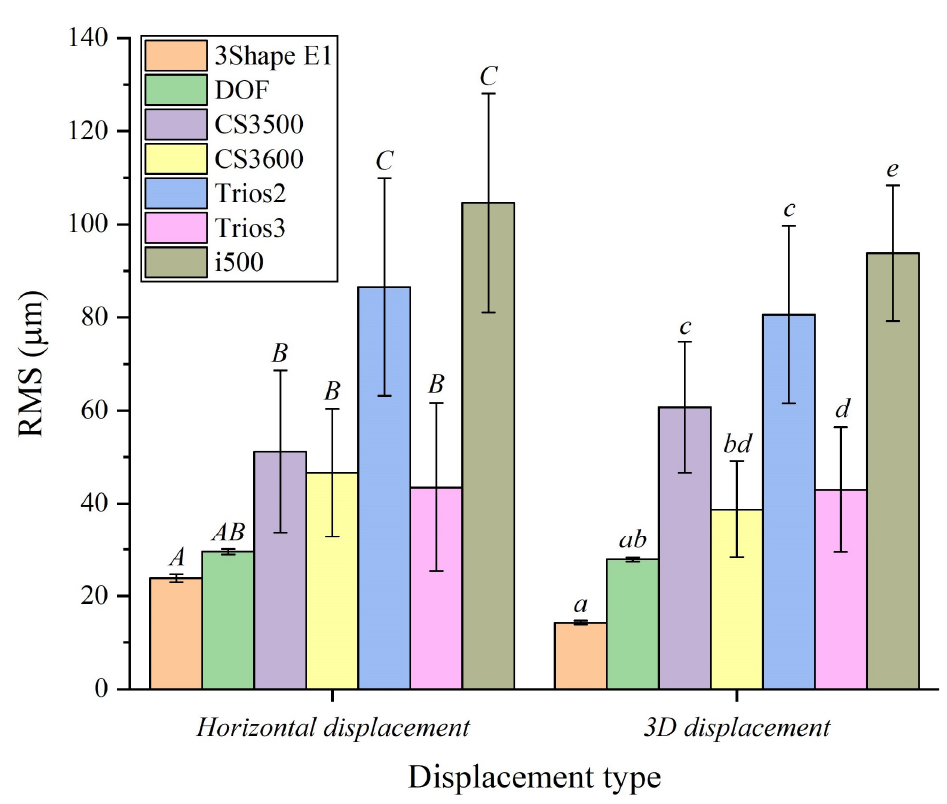
Table 1. Horizontal displacement and 3D displacement according to the 3D scanners.